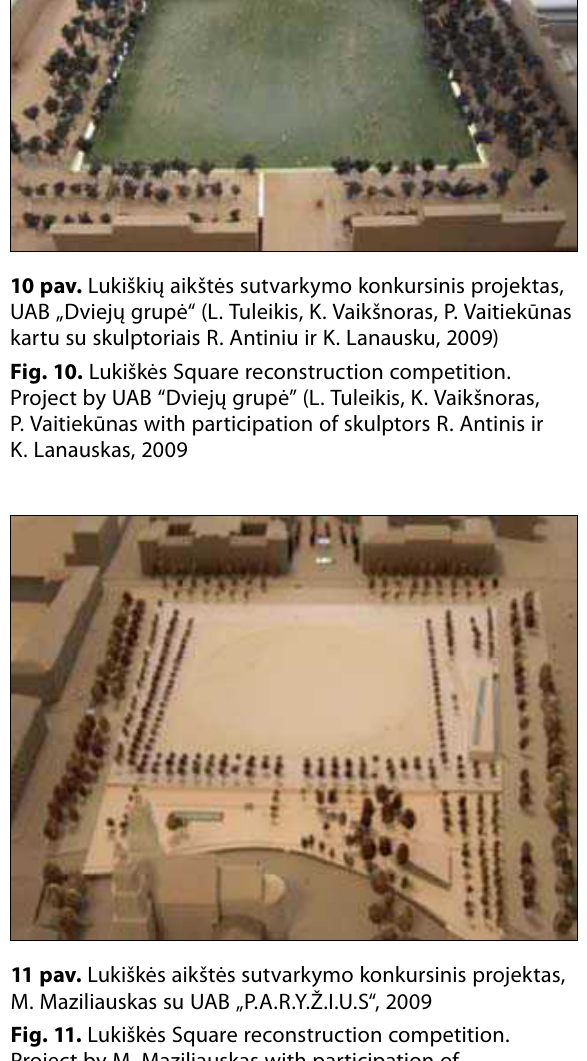
Fig. 11. Lukiškės Square reconstruction